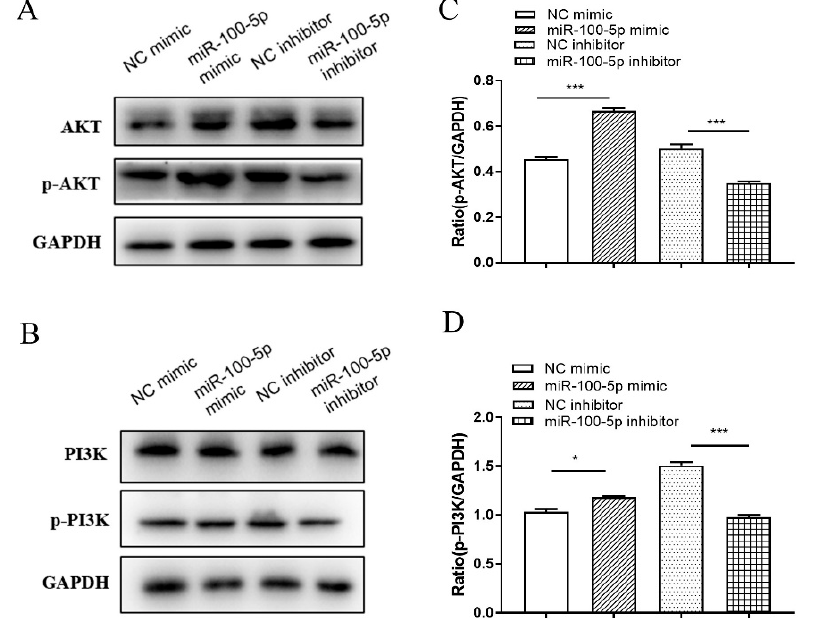
Figure 4. miR-100-5p increases PI3K and AKT phosphorylation. THP-1 cells were transfected with NC mimic, miR-100-5p mimic, NC inhibitor, or miR-100-5p inhibitor for 24 h and infected with BCG at an MOI of 10 for 8 h. ( A , B ) Total proteins were collected at 12 hpi. p-PI3K and p-AKT protein levels were detected by Western blotting assay. ( C , D ) Relative protein expression ratios were analyzed using ImageJ with normalization to GAPDH. Data are representative of three independent experiments (( C , D ), mean ± s.e.m.). * p < 0.05; *** p < 0.001.